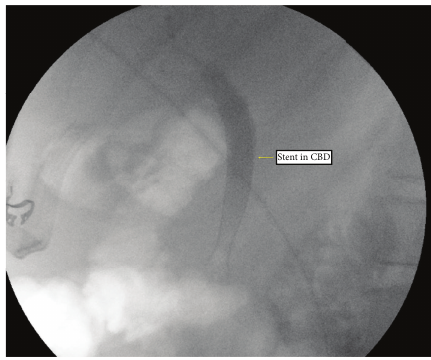
Figure 4: ERCP: occlusive cholangiogram with no